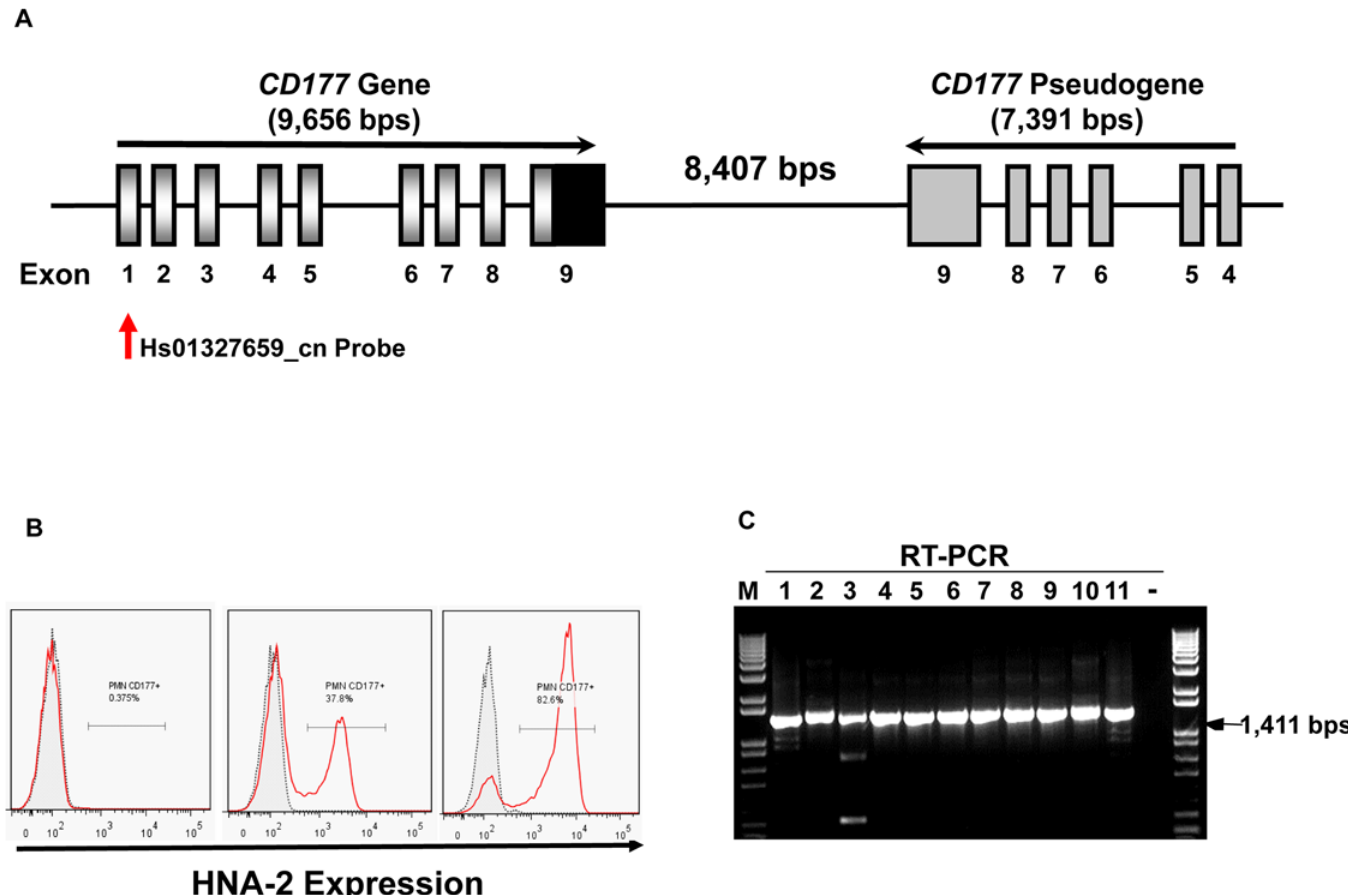
Fig 1. CD177 gene structure and HNA-2 expression. A). Structures of CD177 gene and pseudogene at chromosome 19q13.31 region. CD177 gene with nine exons and its pseudogene with six pseudo-exons are separated by 8,407 nucleotides. CD177 pseudogene is highly homologous to CD177 between exon 4 and 9. Vertical arrow indicates the CNV assay probe location. B). HNA-2 expression varies in different donors. Characteristic light-scatter properties were used to identify neutrophils in flow cytometry. Neutrophils from different donors vary in the percentages of HNA-2 positive cells. Right panel shows the absence of HNA-2 expression on neutrophils from a donor. C). Amplification of full-length CD177 cDNA from HNA-2 deficient donors. All HNA-2 deficiency donors expressed full-length CD177 mRNA the full-length CD177 cDNAs (1,411 bps) were detected in